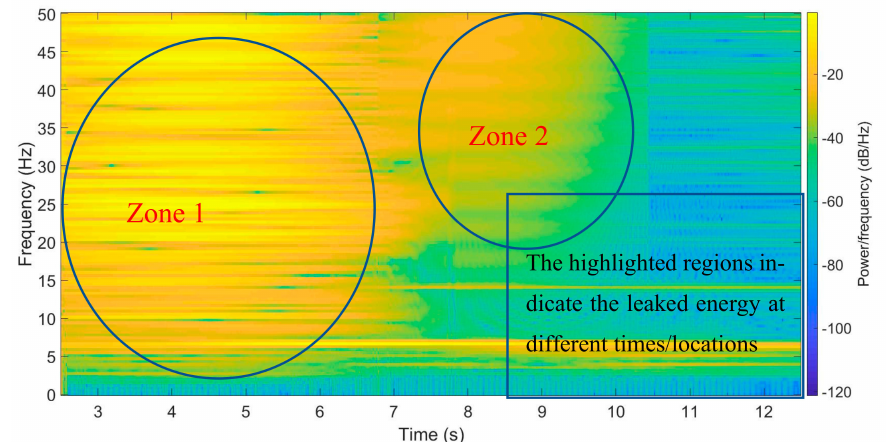
Figure 29. STFT results of vehicle’s right rear axle acceleration difference between the 80% damage case and the healthy